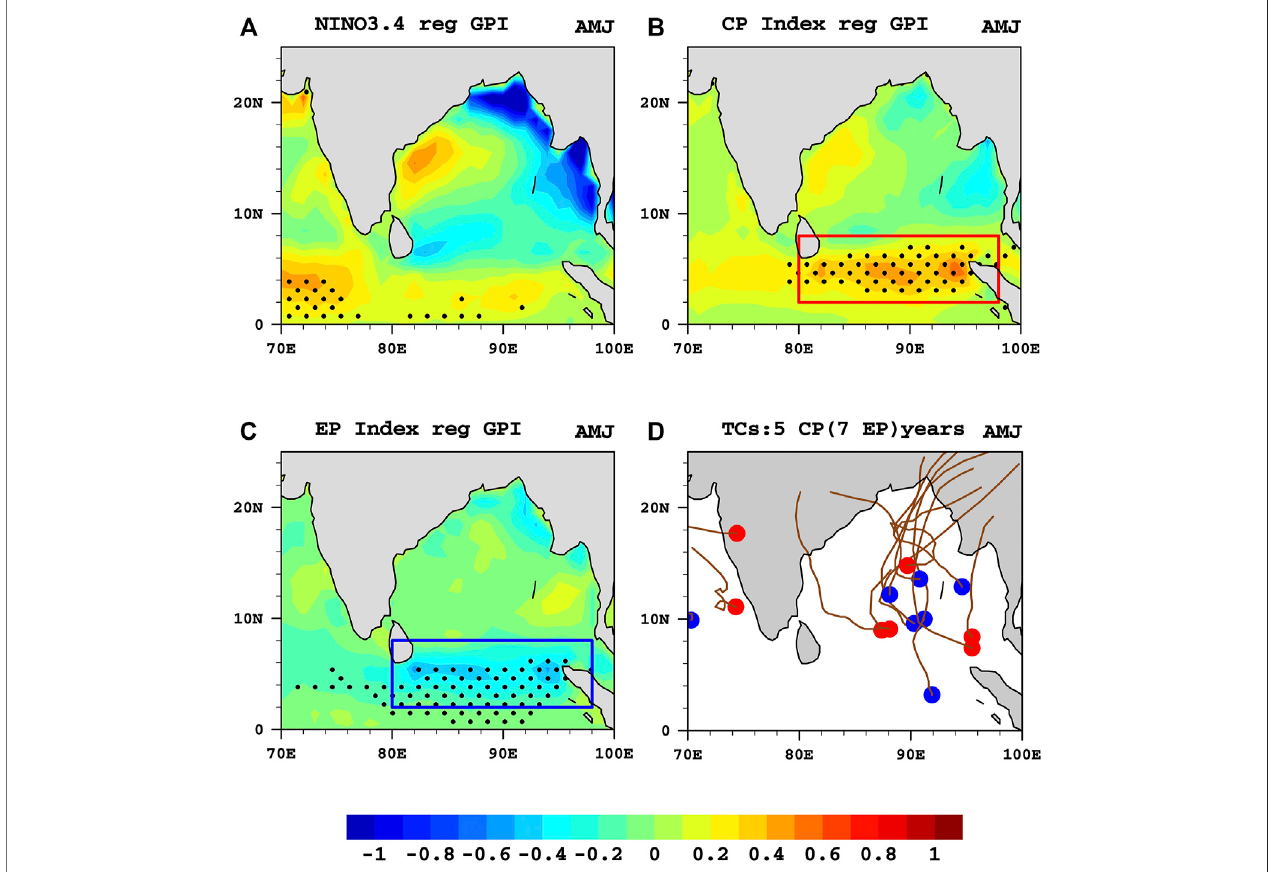
FIGURE 11 | (A) Spatial patterns of GPI anomalies regressed onto the normalized Niño-3.4 index in AMJ. (B, C) Same as ( (A) ), but with the CP and EP indices; stipplings indicate signi fi cant anomalies exceeding the 95% con fi dence level. The red box indicates a GPI increase, while the blue indicates a reduction. (D) TC genesis and tracks over the northern Indian Ocean during EP type (blue) and CP type El Niño (red); each dot represents a tropical cyclone genesis point.